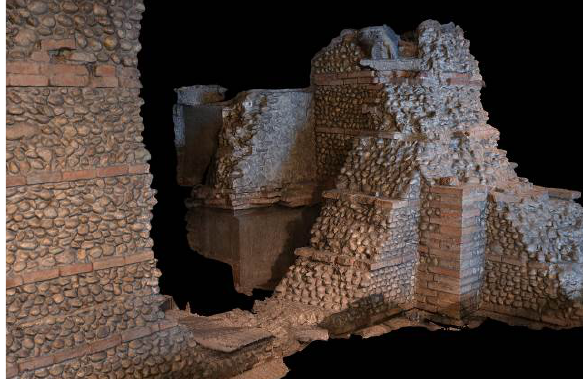
Figure 9. View of the textured three-dimensional model of the